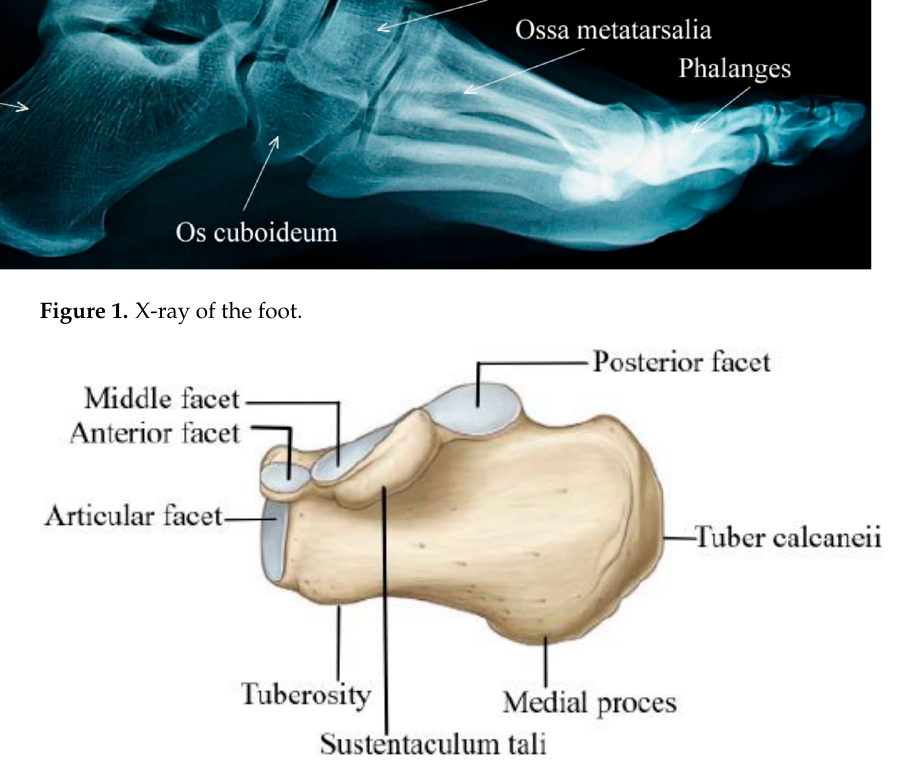
Figure 2. Anatomy–joint surfaces of the heel bone.